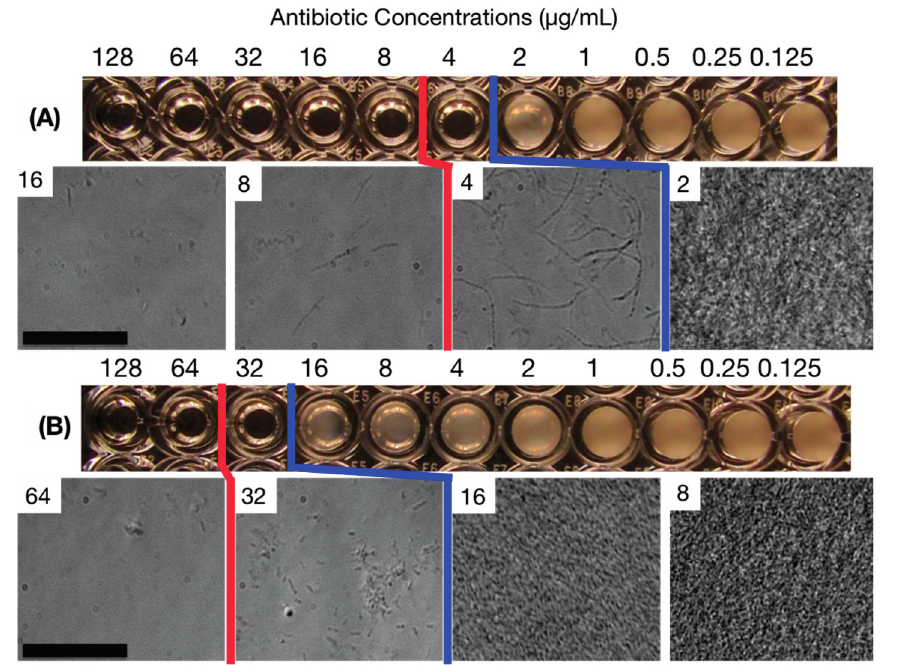
Figure 3. Off-chip MIC determination of E. coli based on the SBM method (22 h of incubation): ( A ) ampicillin and ( B ) streptomycin. MIC determination criteria by visual